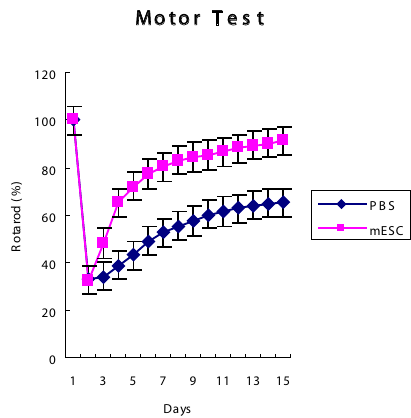
FIGURE 4A - Motor functions were examined between control group and mESC-transplanted group. Cell transplantation enhanced motor ability after ischemia. Scores were compared to baseline data generated before stroke and are represented as % of control. P<0.05 compared with PBS (n=10) only; P<0.05 compared with cell transplanted group (n=14).